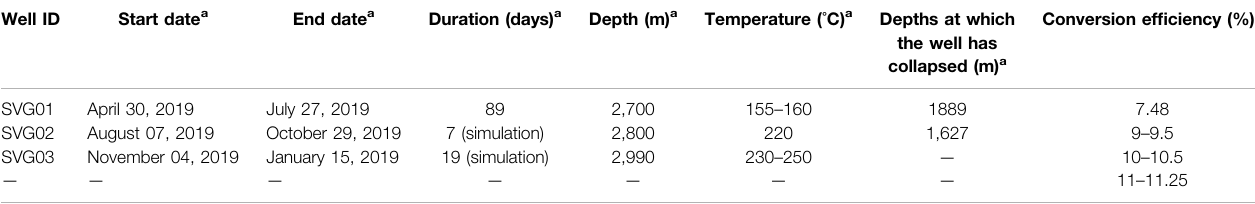
Figure 5 entails two geothermal well pads (W1 and W3), each consisting of three wells. The SVGP phase I exploratory drilling includes drilling deep wells (between 1 km and 3 km in depth) into the Earth ’ s crust which will then classify the thermal energy found in underground reservoirs of being either geothermal water or steam in composition. In addition, Richter (2019) stated that the preliminary well reached a depth of 2.8 km and collapsed in the last 1 km segment without permeability.